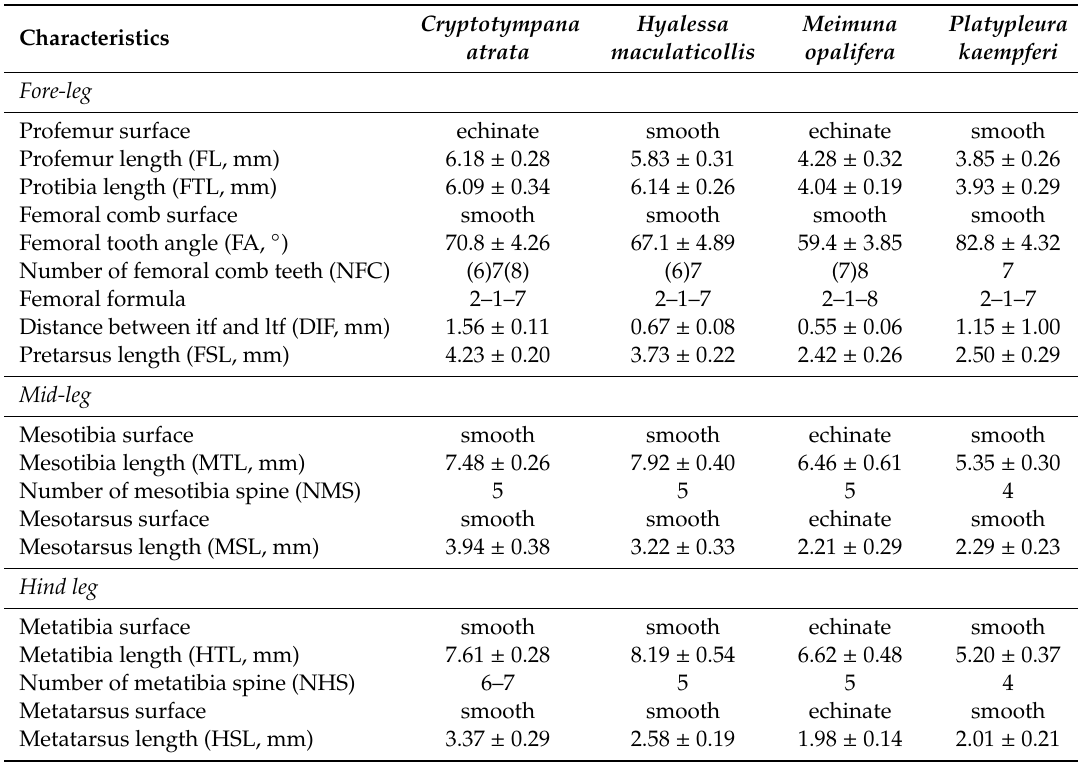
Table 1. Surface patterns and measurements (mean ± S.D.) of fore-, mid-, and hind legs characteristics of four Cicadas species in